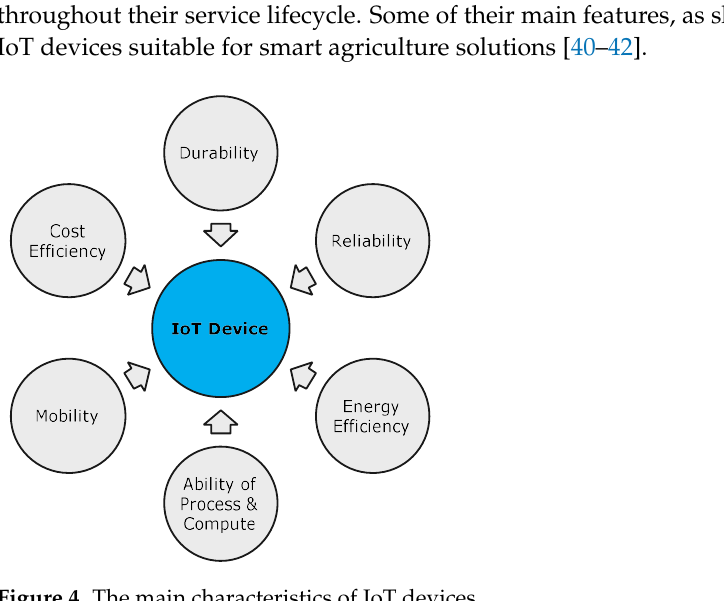
Figure 4. The main characteristics of IoT devices.